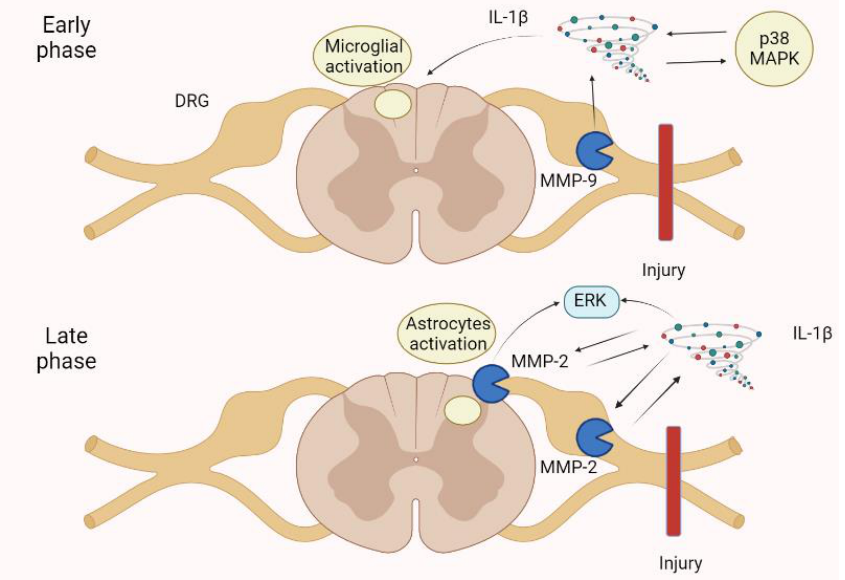
Figure 6. Neuropathic pain is spinal cord injury shows an early phase in which an MMP-9 increase in the DRG activates IL- 1β, p38 MAPK, and then microglia. In the late phase, an MMP-2 increase in the DRG and spinal cord astrocytes determines a further enhancement of IL- 1β and the ERK. These mechanisms augment pain perception and persistence, leading to neuropathic pain. ERK, extracel- lular-signal-regulated kinase; IL, interleukin; MAPK, mitogen-activated protein kinase.